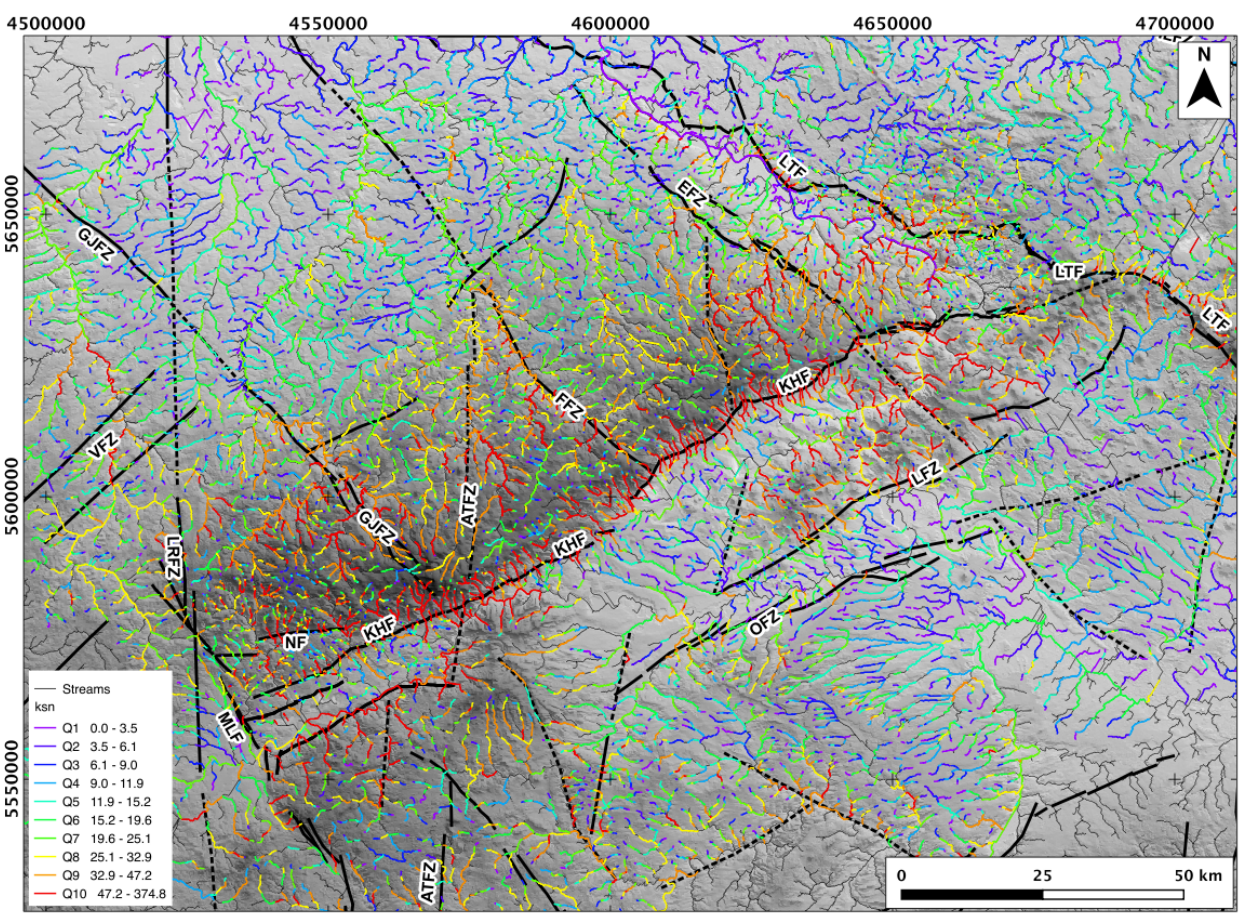
Figure 11. Normalized steepness indices ( k ) extracted from stream longitudinal profiles. sn Values are classified using 10 quantiles (denoted Q1 to Q10). Bold lines represent the simplified trace of major lineaments (see Figure 2 for